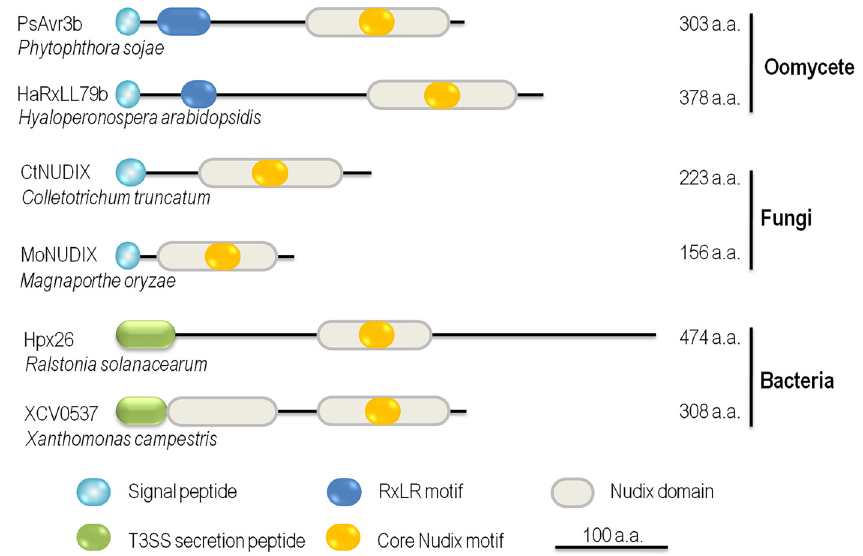
Fig 1. Nudix effectors from pathogens across the kingdoms. Six reported Nudix effectors from pathogenic oomycetes, fungi, and bacteria are presented. PsAvr3b is an effector from soybean Phytophthora root rot pathogen isolate P6497 [9]. HaRxLL79b is an in planta -induced RXLR-like effector identified in Arabidopsis downy mildew H . parasitica isolate Waco9 [19]. Nudix effectors CtNUDIX and MoNUDIX are derived from two hemibiotrophic fungi: a broad host range Colletotrichum pathogen and the rice blast causal agent Magnaporthe oryzae , respectively [15]. Both Hox26 and XCV0537 are type III secretory effectors from vascular wilt bacteria and pepper or tomato leaf spot bacteria [8,11]. The effectors are drawn to scale, with the scale bar provided at the bottom of the